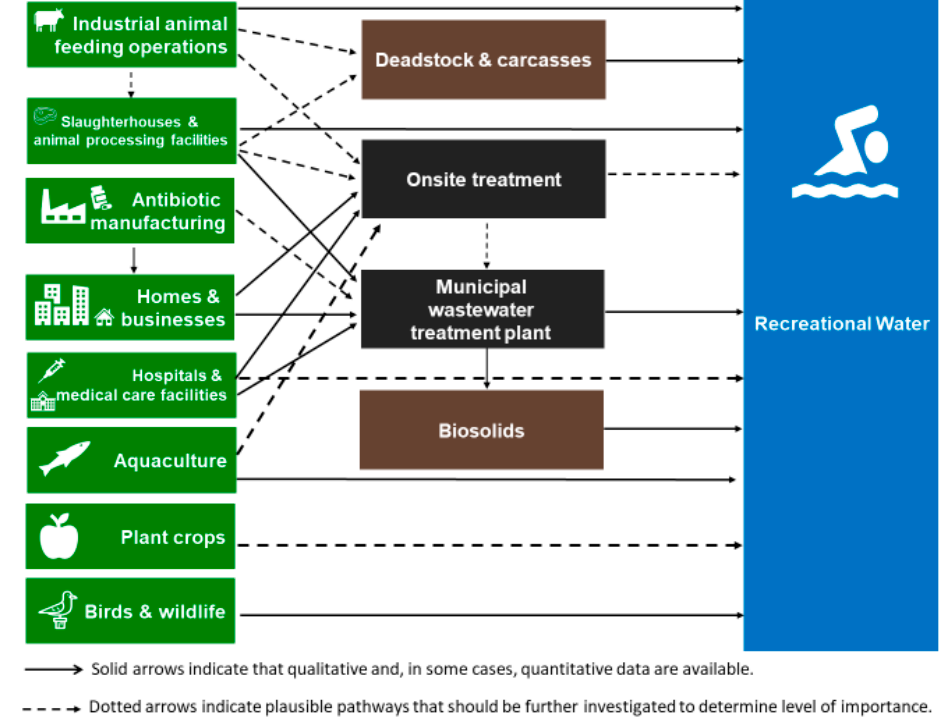
Figure 1. Potential sources of antimicrobial resistant (AMR) bacteria and antimicrobial resistant genes (ARGs) contributing to recreational surface water exposures.